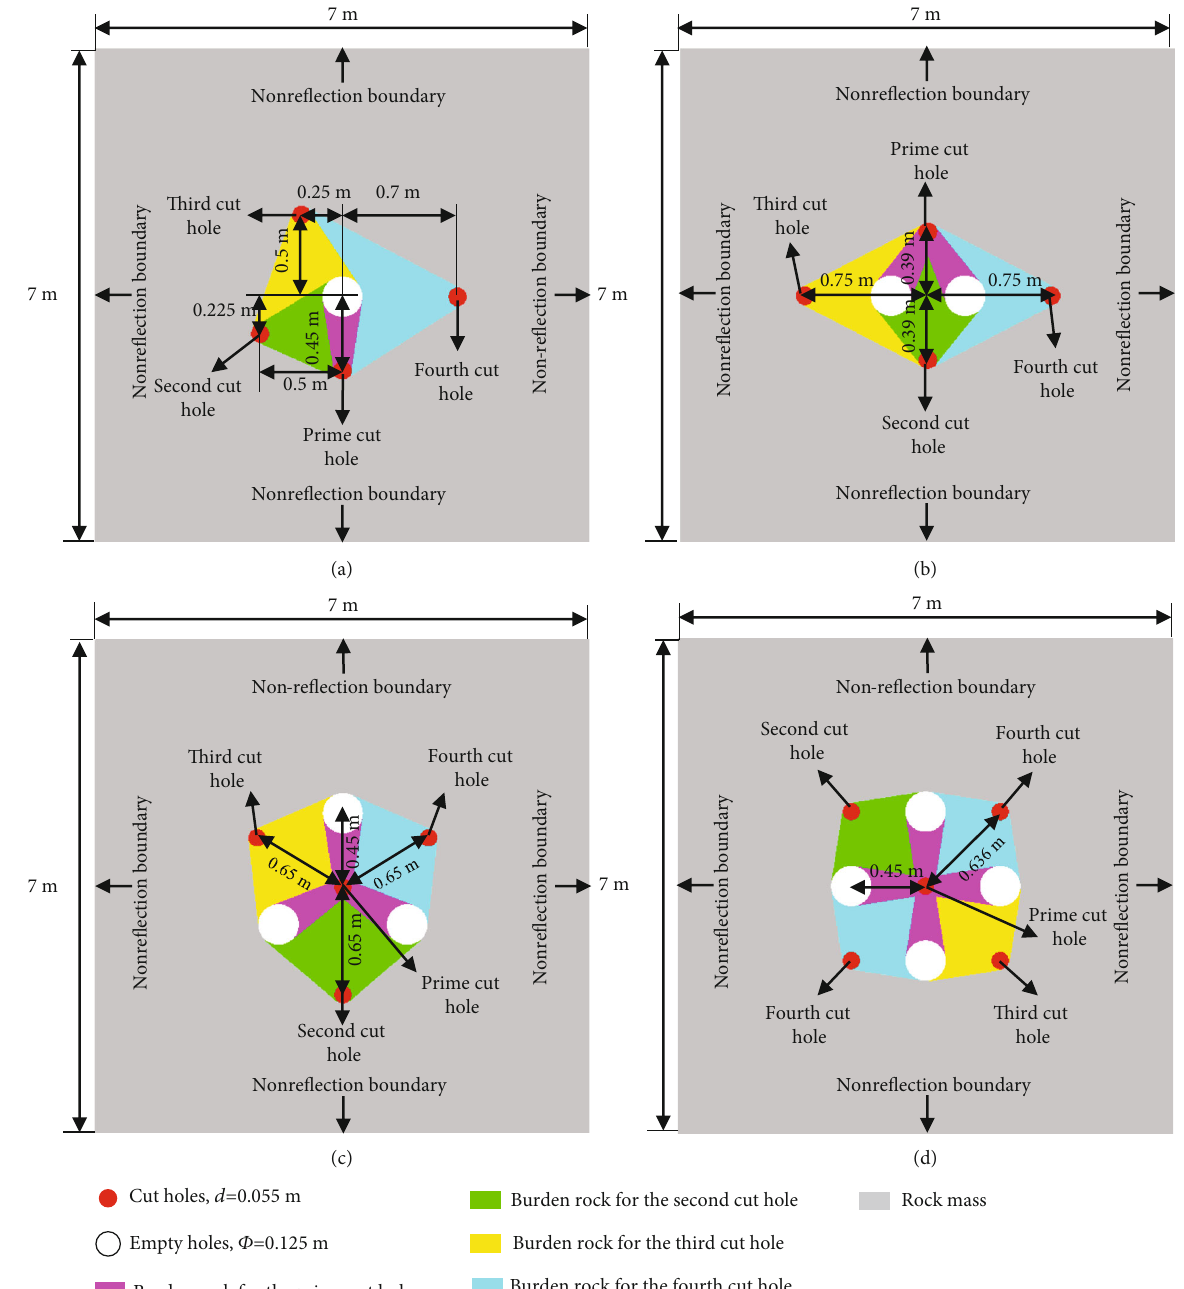
Figure 11: Four types of burn cut models with geometry and boundary conditions: (a) spiral cut, (b) diamond cut, (c) triangular prism cut, and (d) doliform